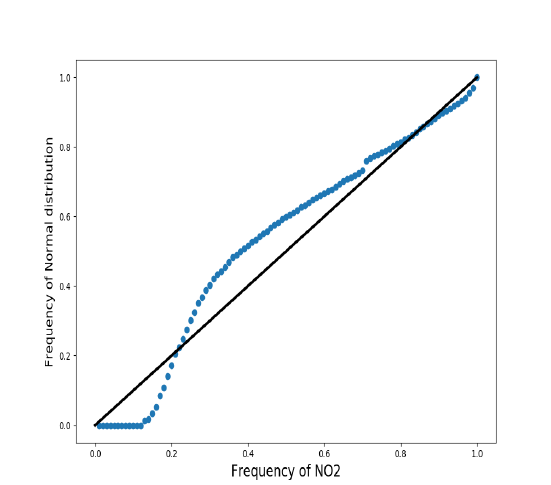
Figure 4. Normal probability plot of hourly NO 2 (QQ-plot) concentrations from Blanchardstown air quality monitoring station. Software: Python